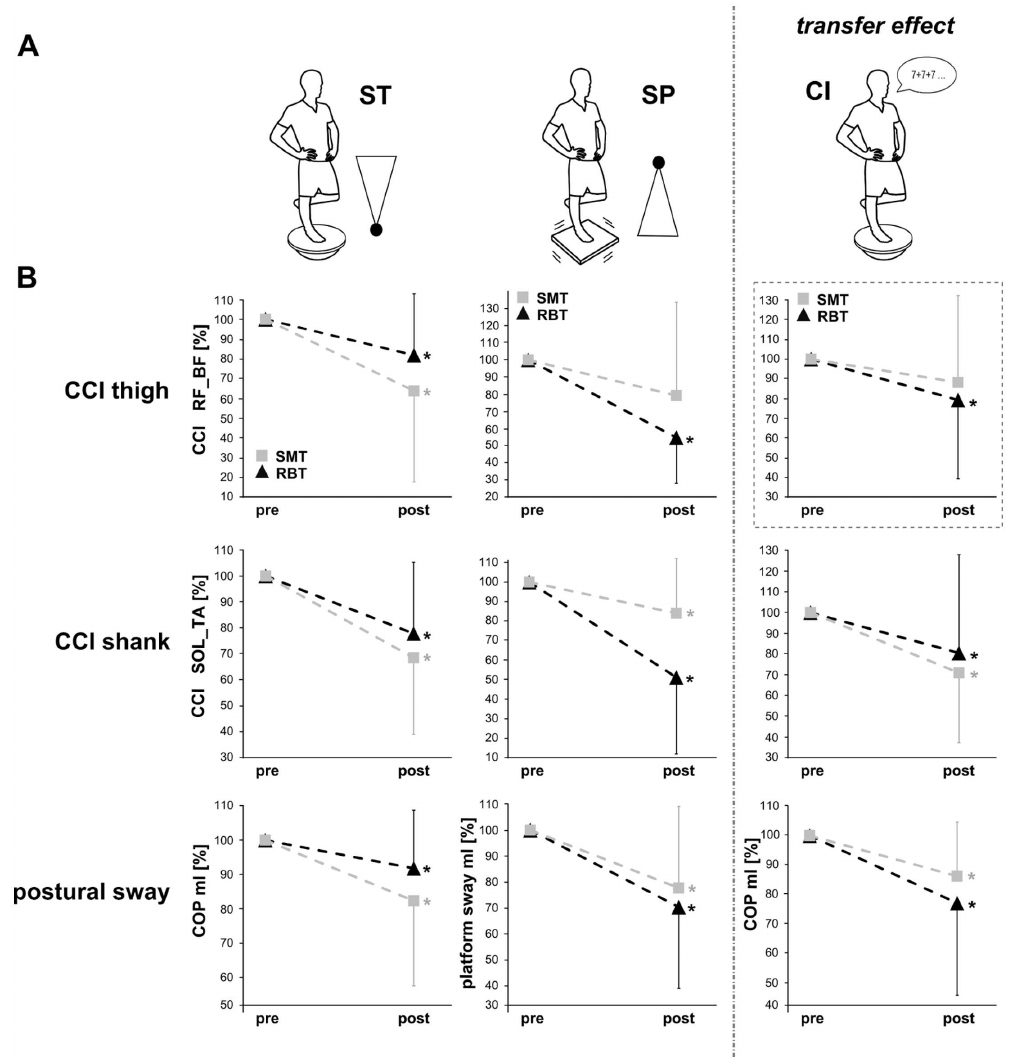
Fig 2. Changes in neuromuscular activation and postural sway in response to both interventions. (B) Changesin thigh (upper row) and shank (middle row) CCIs as well as COP ml /postural sway (bottom row) in responseto the traininginterventions SMT (grey square) and RBT (black triangle)in (A) the three different test paradigmson the spinningtop (ST, left column), on the swingingplatform (SP, middlecolumn)and duringthe transfer conditionwith cognitive interference (CI, right column). Adaptations in all parameters were greater in the SMT-group than in the RBT-group for ST, whereas duringSP, adaptations were greater in the RBT-group than in the SMT-group. For CI, a greater reductionin COP ml displacement was observedin the RBT-group: it is assumed that the higherdecreasein thigh CCI (dashedbox) led to the better